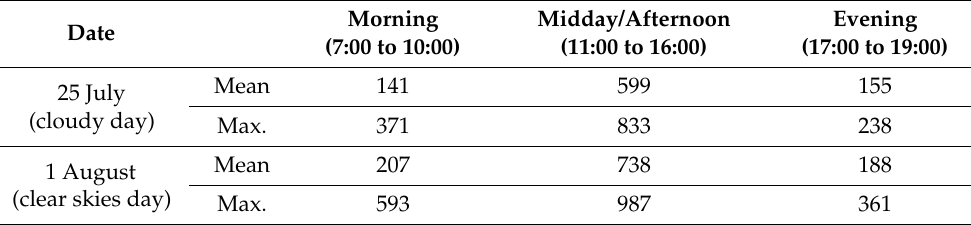
Table 4. Mean and maximum solar irradiance values (Watt/m 2 ) registered in station 322 of SERIS (close to Duxton Park) during different periods of the day on 25 July and 1 August 2019.